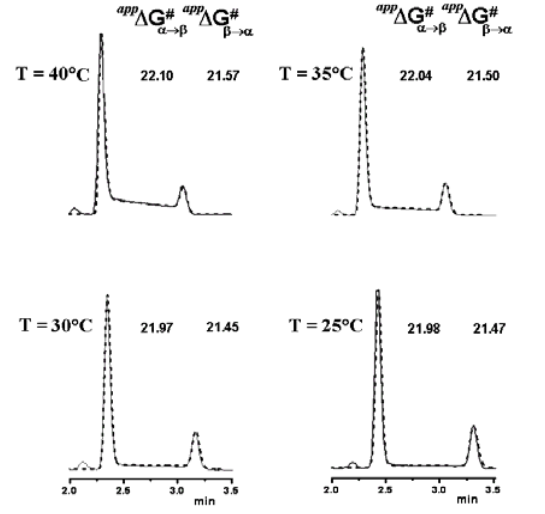
Figure 8. Variable temperature chromatographic profiles obtained on the Symmetry C column. Solid line: experimental chromatograms. Dotted line: computer simulated profiles obtained with the measured free energy activation barriers for the on-column epimerization process. Reproduced from Figure 7 in Reference [41] with permission from